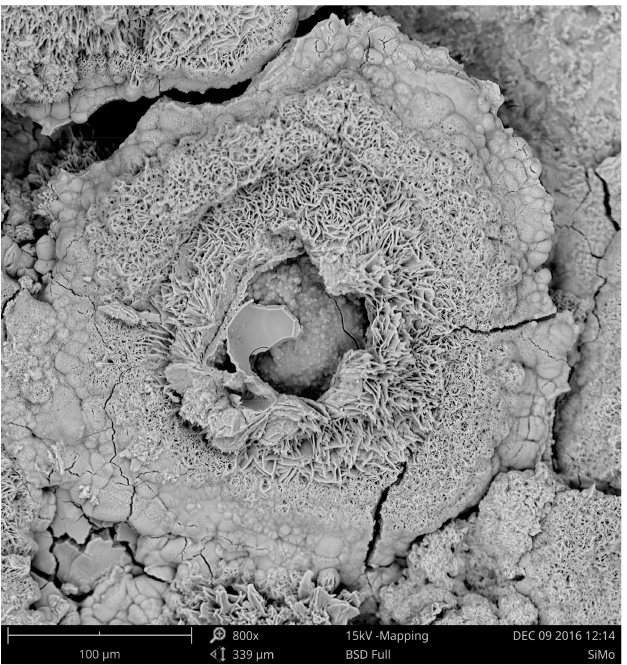
Figure 10. Area of ductile iron casting covered with pitting